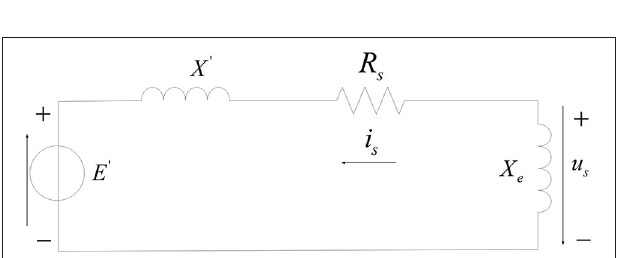
FIGURE 3 | Simplified equivalent circuit of